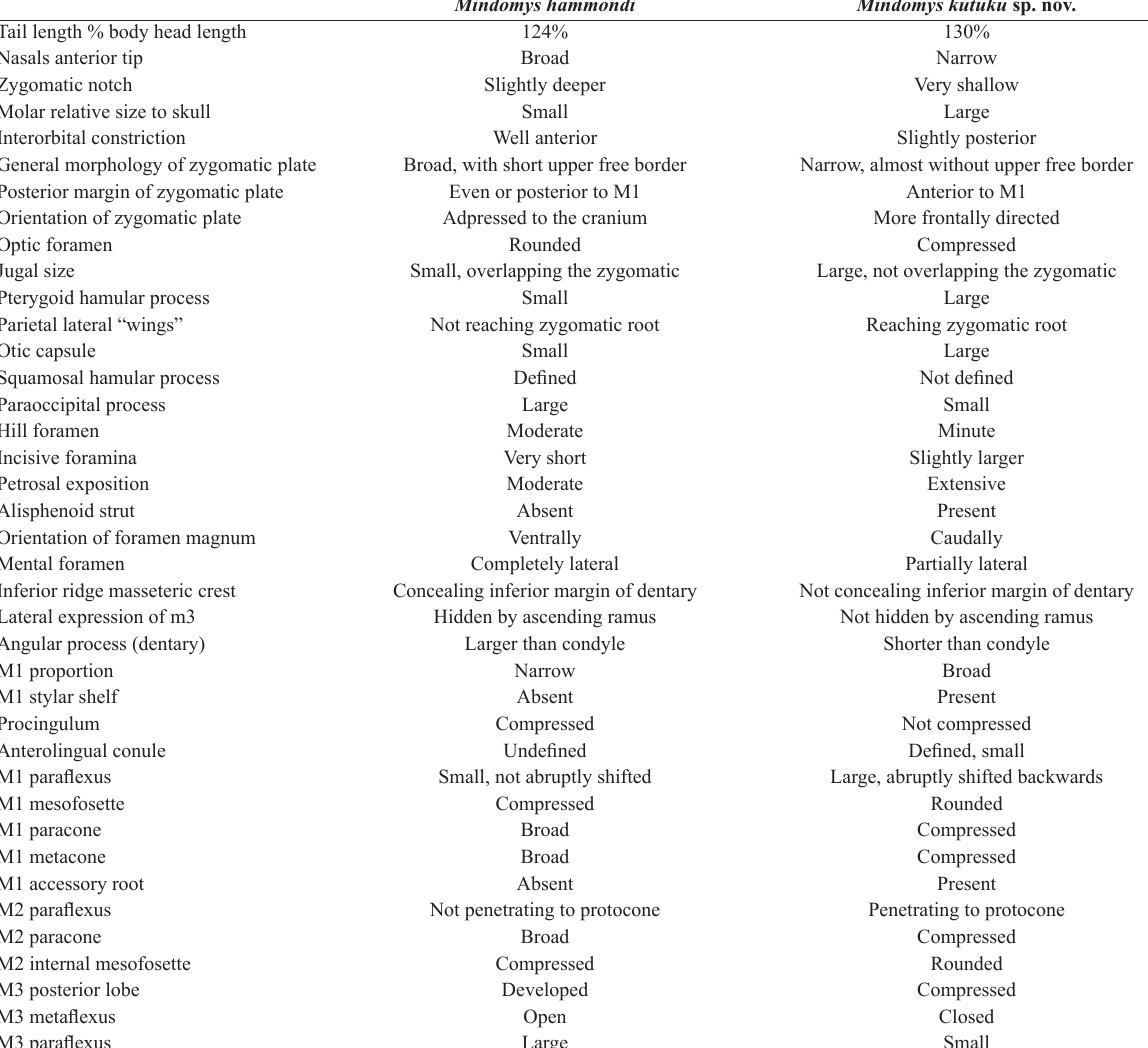
Table 4. Main differential craniodental traits between species of the genus Mindomys (Oryzomyini,